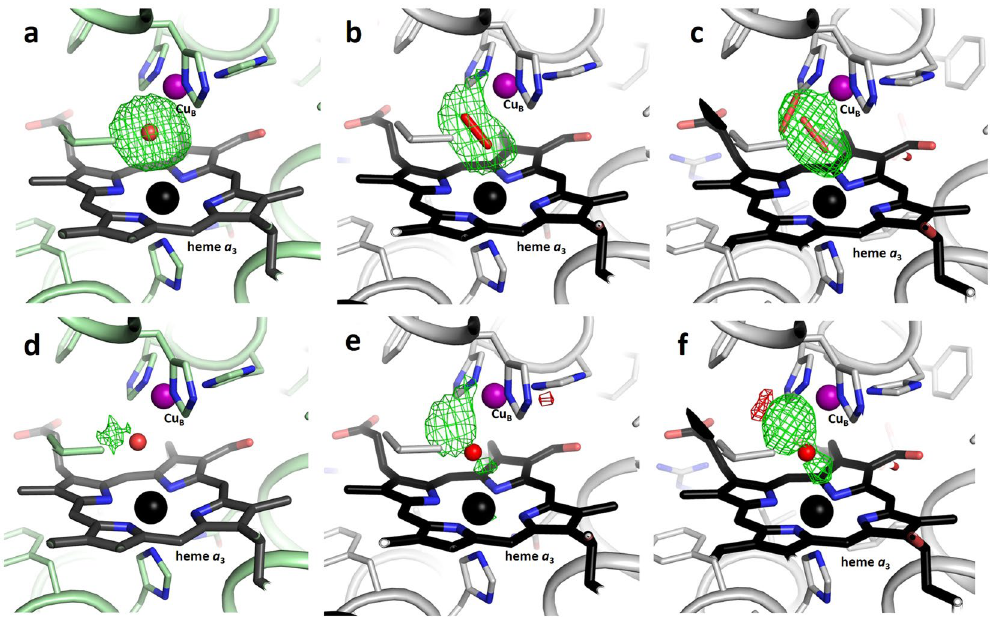
Figure 4. Comparison of active site electron densities. ( a – c ) F o -F c omit map densities (green) contoured at 4.5 σ , calculated without any active site ligands. ( a ) The omit map density of ba 3 C c O from SFX data. The bound water molecule/hydroxide ion is shown in red. ( b ) The omit map density of ba 3 C c O from cryo-LCP data (PDB code 3S8G). The bound peroxide molecule is shown in red. ( c ) The omit map density of bovine heart aa 3 -type C c O from XFEL data of large crystals at cryo temperature (PDB code 3WG7). Two bound peroxide molecules with partial occupancies are shown in red. ( d – f ) F o -F c difference densities calculated with a water molecule bound in the active site are shown in green (positive) and red (negative), contoured at + 4.0/ − 4.0 σ . The bound water molecules are shown in red. ( d ) The F o -F c density of ba 3 C c O from SFX data. ( e ) The F o -F c density of ba 3 C c O from cryo-LCP data (PDB code 3S8G). ( f ) The F o -F c density of bovine heart aa 3 -type C c O from XFEL data of large crystals at cryo temperature (PDB code